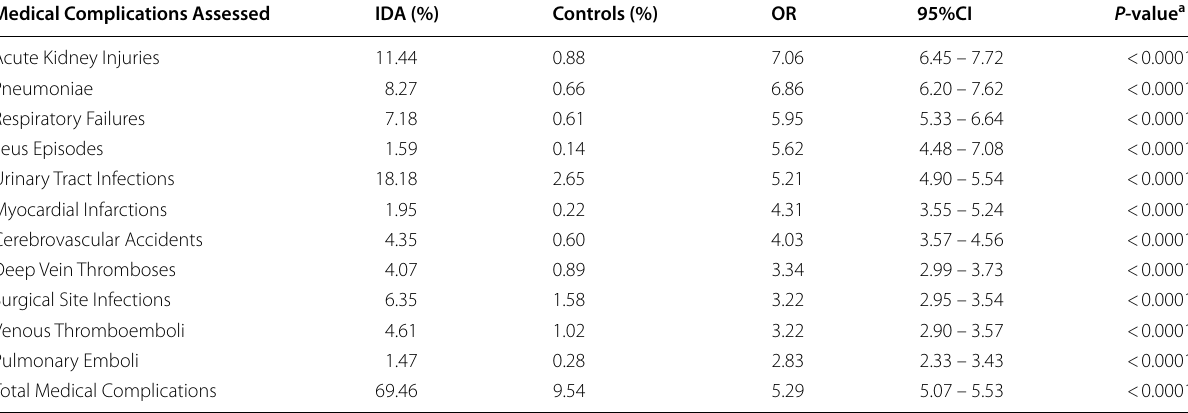
Table 2 Differences in ninety-day medical complications following revision total knee arthroplasty in iron deficiency anemia patients and